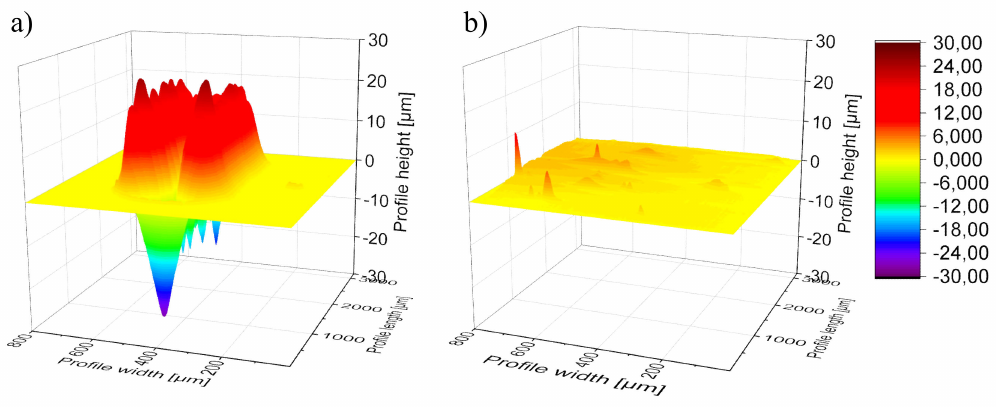
Figure 3. Surface profile of ( a ) the scratch and ( b ) after 20 h healing at 100 ◦ C of metallopolymer P4